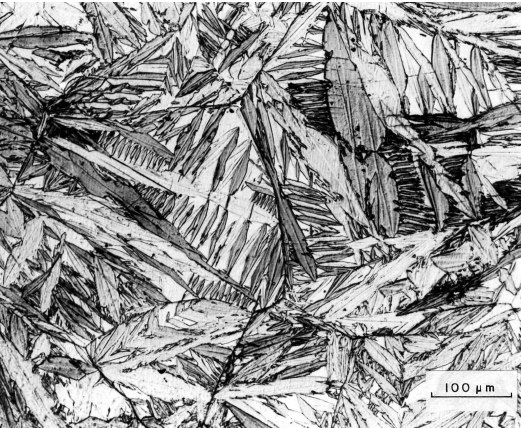
Figure 1. Microstructure of martensite transformation in Fe-31wt%Ni-0.02wt%C transformed by cooling into liquid nitrogen. Micrograph obtained by J. R. C.